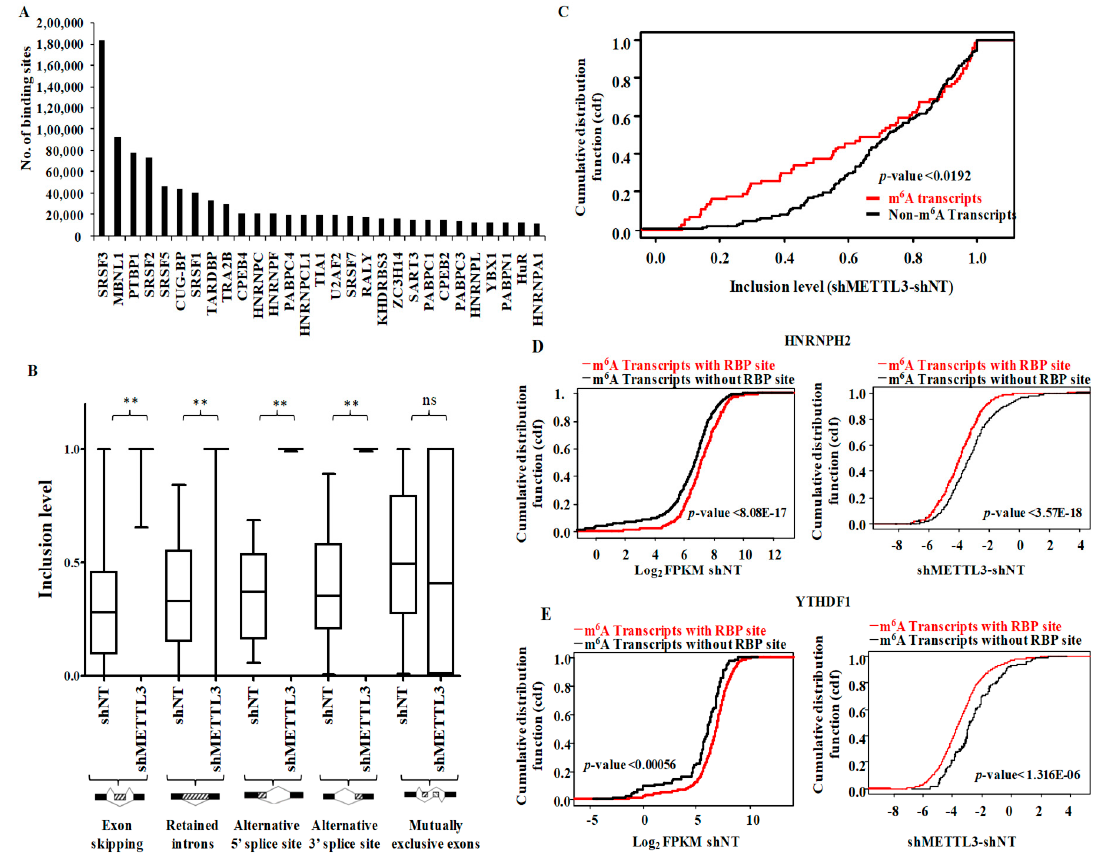
Figure 4. Inter-play of METTL3-dependent m 6 A modification in post-transcriptional RNA